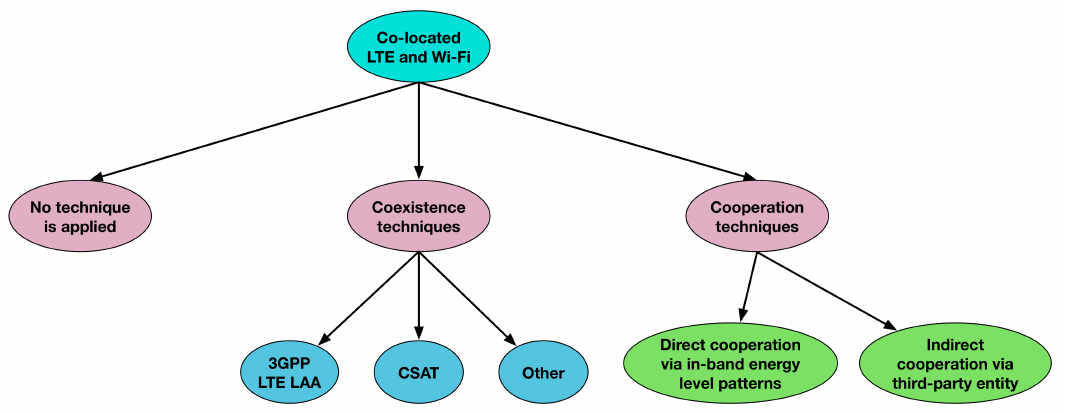
Figure 2. Taxonomy of the techniques that can be applied to co-located LTE and Wi-Fi